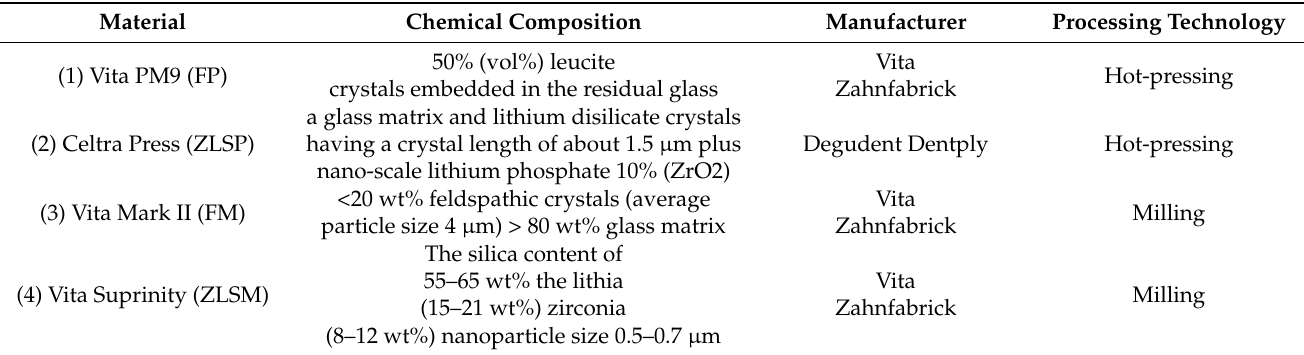
Table 1. Ceramic dental materials with their composition